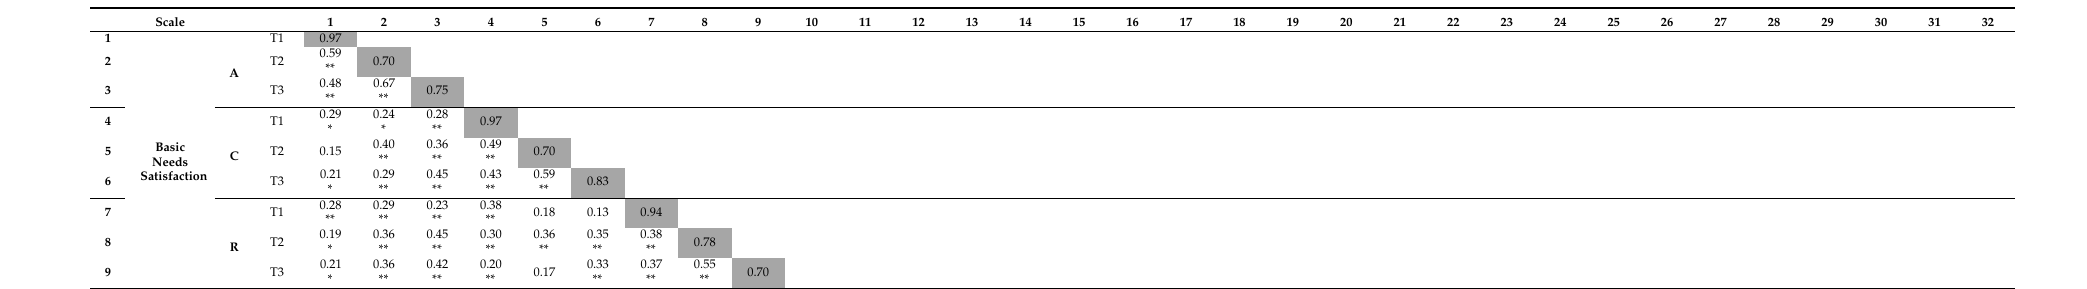
Table 2. Simple Correlations between Study